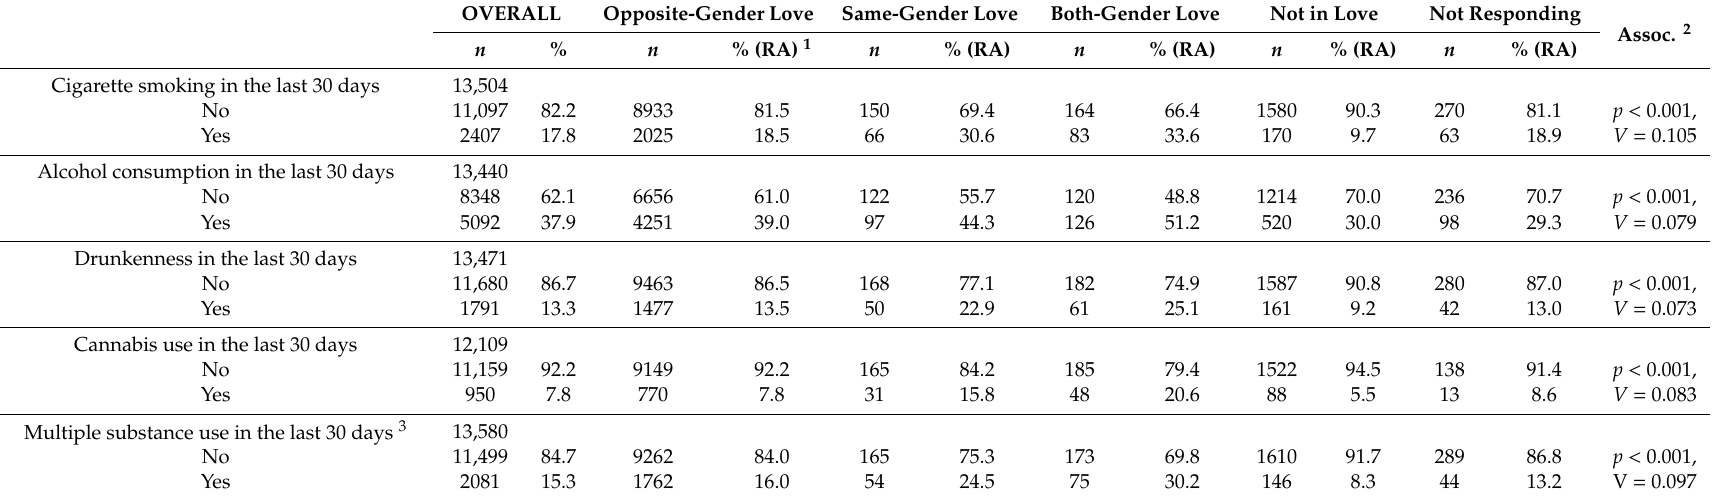
Table 2. Frequency of risk behaviors, overall and by romantic